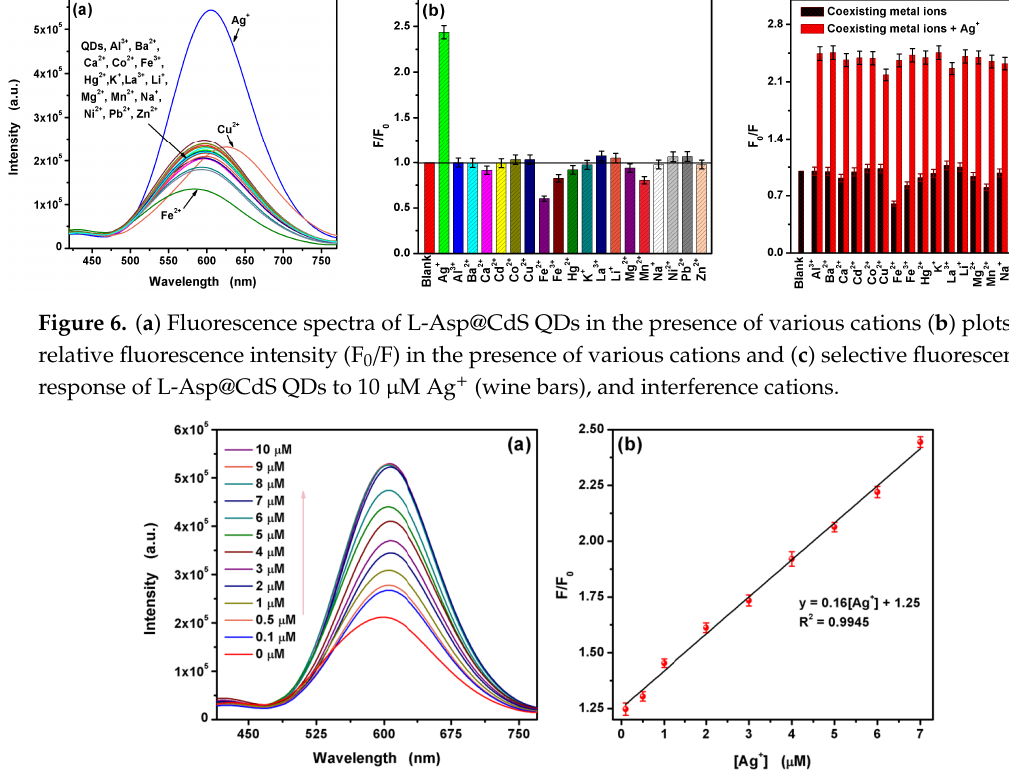
Figure 7. ( a ) Fluorescence spectra of synthesized L-Asp@CdS QDs solution upon addition of various concentrations of Ag + , ( b ) relative fluorescence intensity of L-Asp@CdS QDs in the presence of various concentrations of Ag + (the error bar indicates the standard deviation, which was obtained by repeated the experiments 5 times). Table 1. Comparison the analytical performance of Ag + detection based on fluorescence assay. Fluorescent Probe